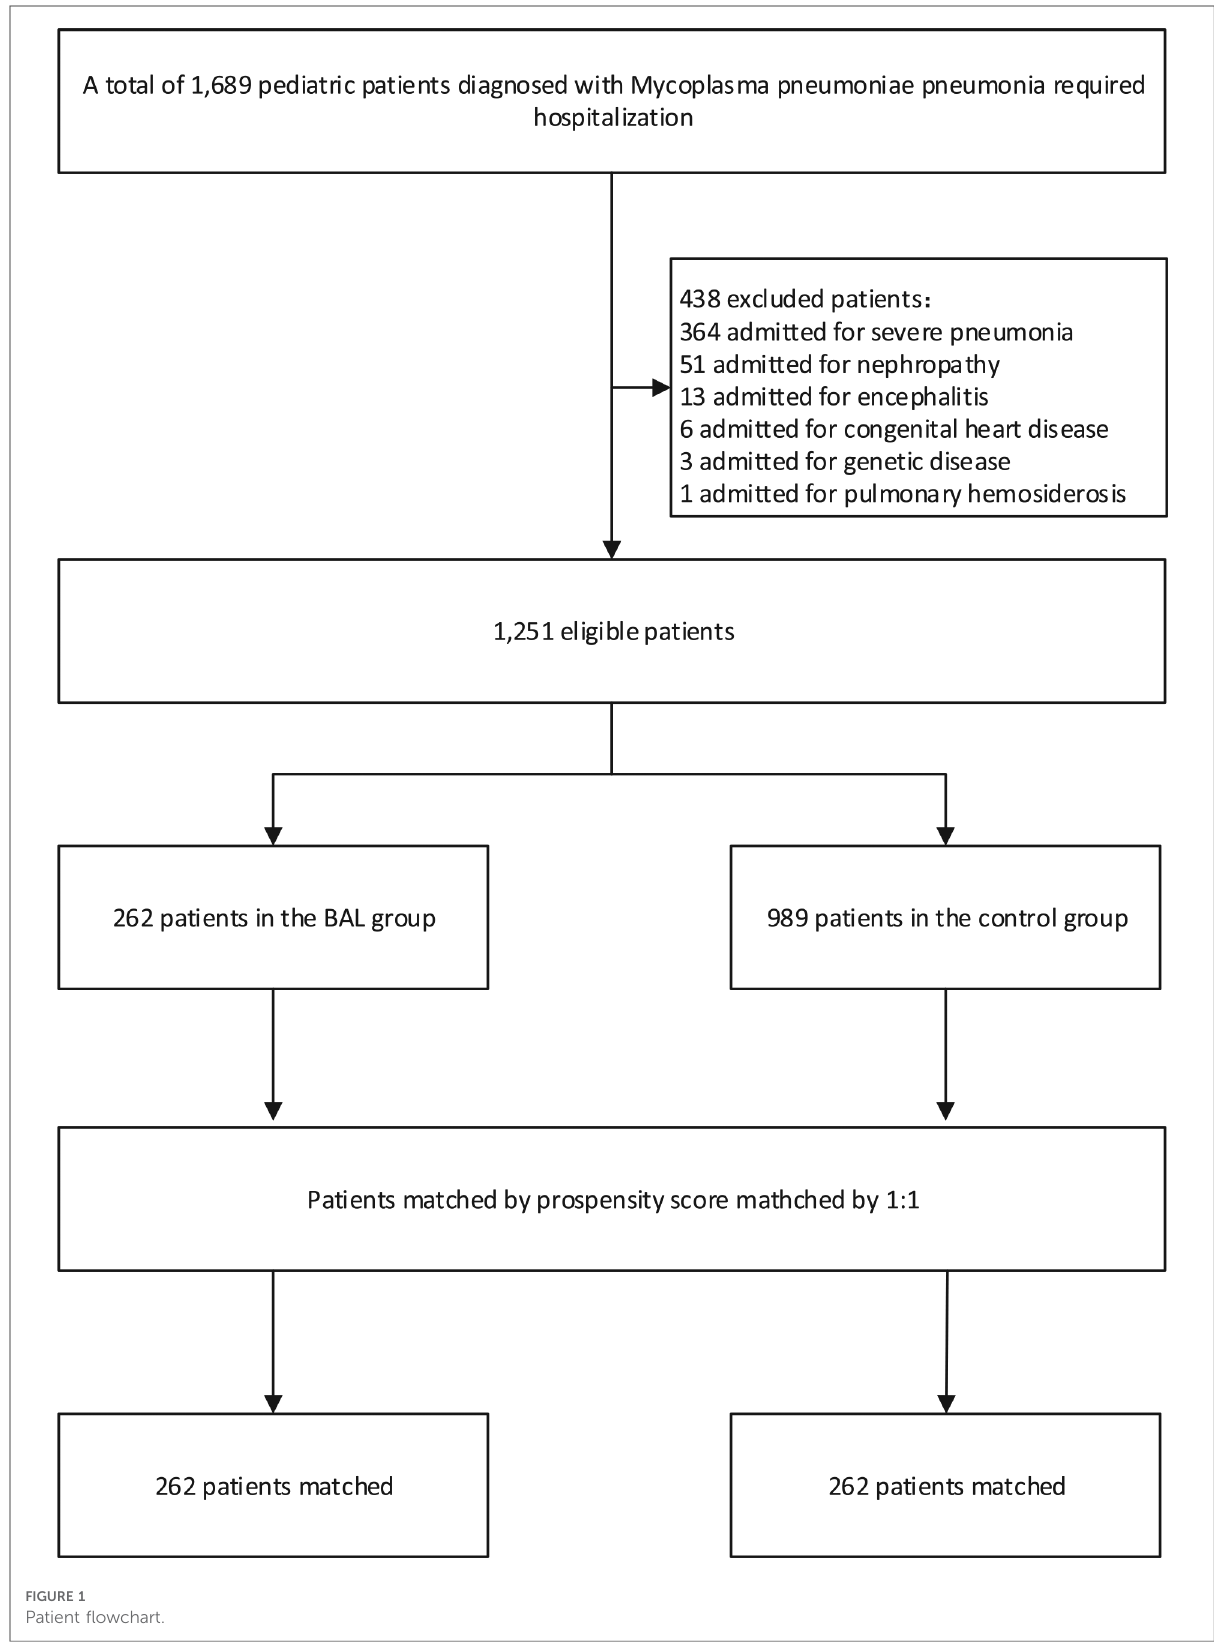
FIGURE 1 Patient fl